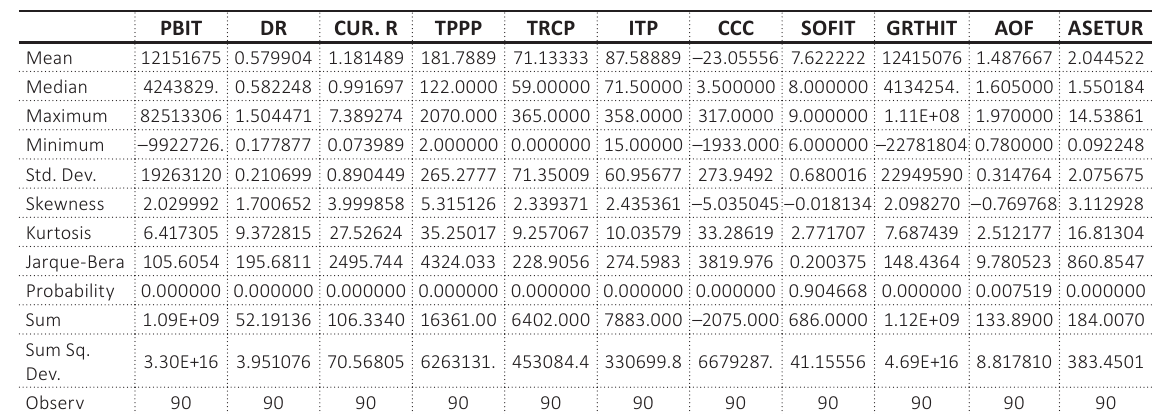
Table 1. Descriptive statistics of variables under the model